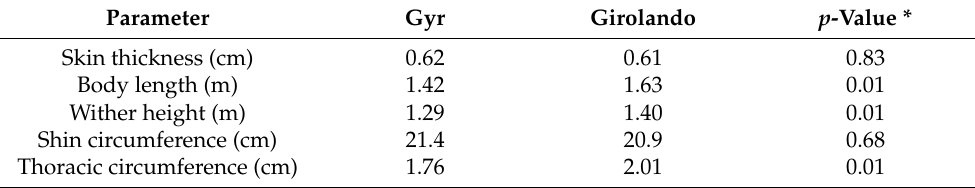
Table 3. Average skin thickness, body length, wither height, shin, and thoracic length according to the genetic group of cows.